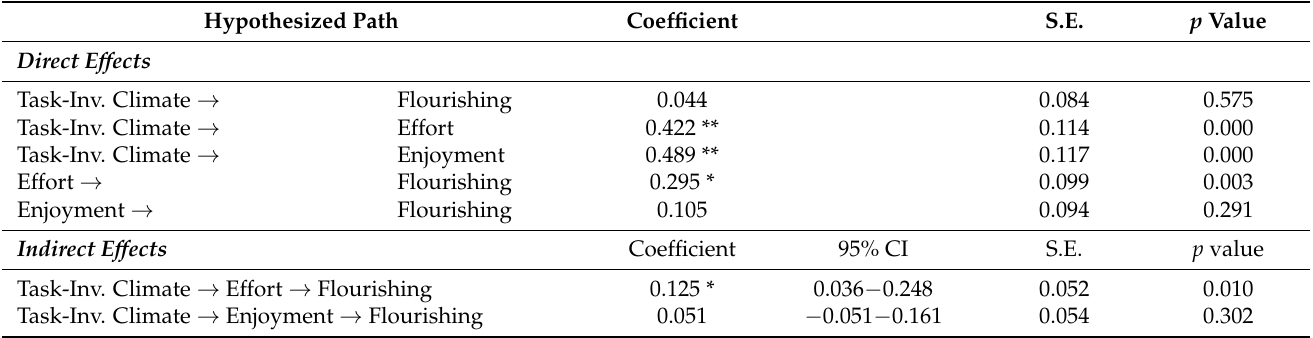
Figure 4. Mediation Analyses: Model 3. Note: Model fit (CFI = 0.90, TLI = 0.88, RMSEA = 0.06, and SRMR = 0.06). Significant theory-driven regression paths (** p ≤ 0.001) are presented in the model. The standardized regression coefficients are presented for each significant path. The significant indirect effect was: Task-Involving Climate → Effort → Flourishing (0.12). Table 5. Model 3 parameter estimates, standard error, and p values.